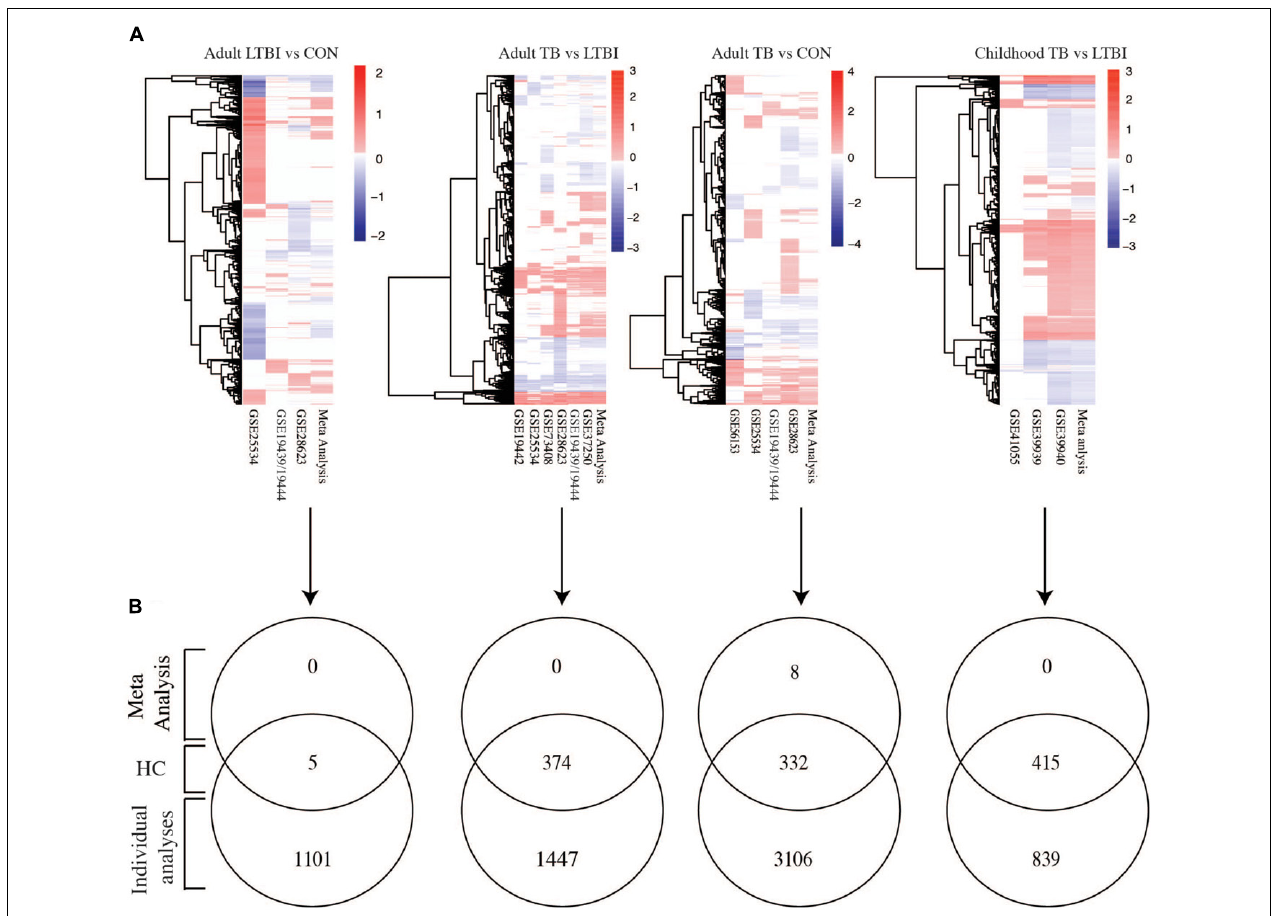
FIGURE 2 | Meta-analysis identified highly robust confidence genes. (A) Heatmaps showing fold changes of differential expression obtained from meta-analysis using the RankProd and individual dataset specific analysis. (B) Venn diagrams comparing genes obtained from meta-analysis and individual dataset specific analysis to identify high confidence genes. HC, high confidence genes, which are consistently identified by both the meta-analysis and individual dataset specific approaches. TB, tuberculosis; LTBI, latent TB infection; CON, uninfected controls. Fold change cut-off 1.5, p -value <